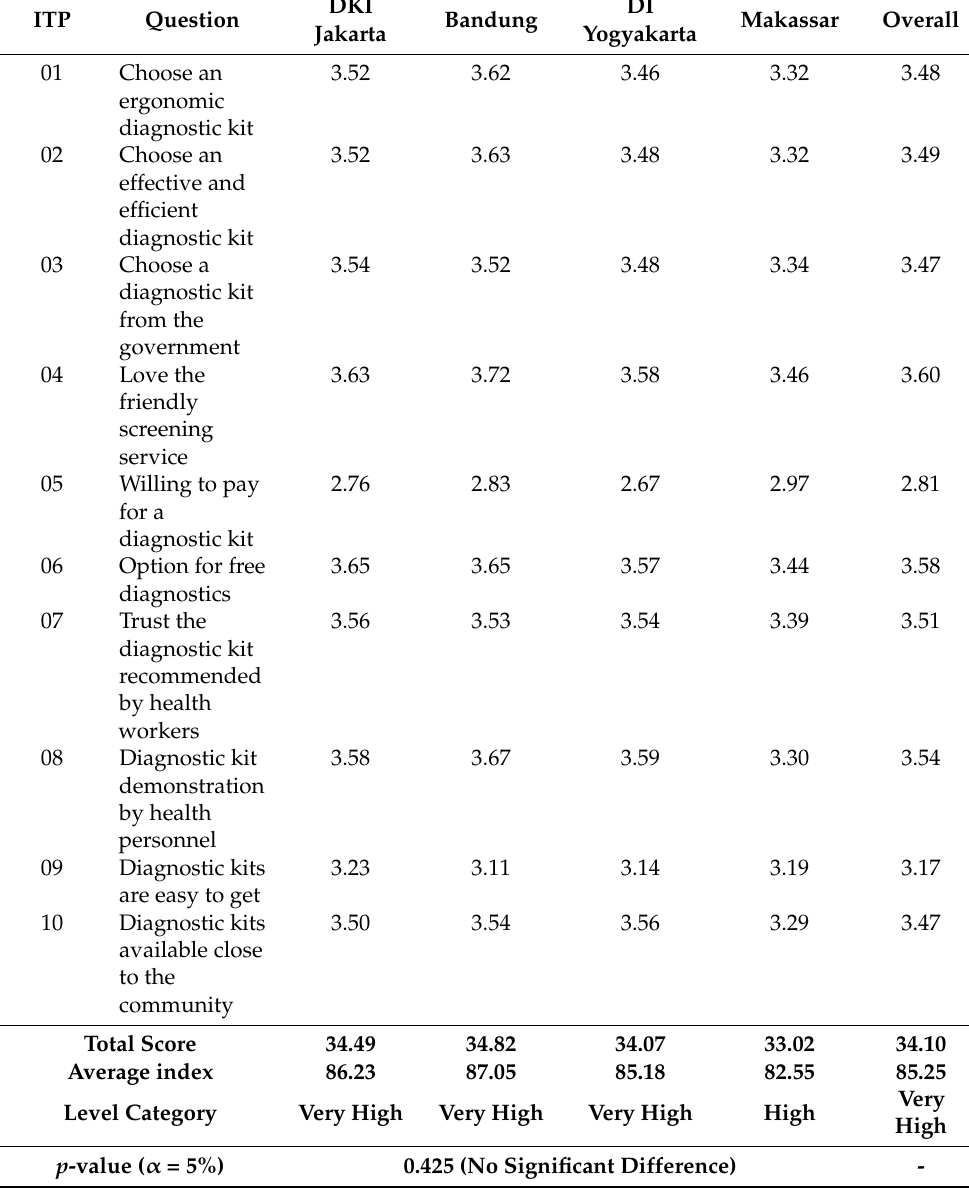
Table 6. Willingness and Intention for Hepatitis B